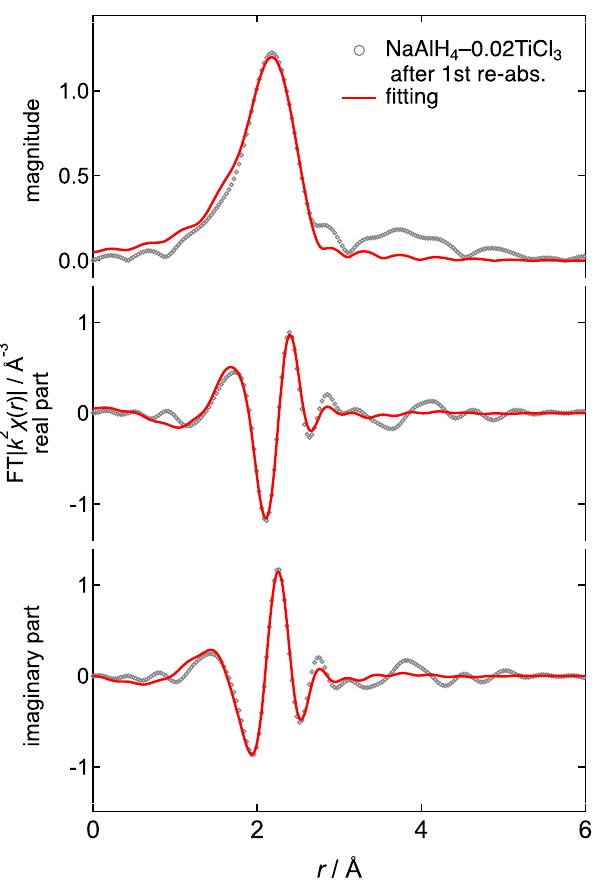
Figure 7. Fitting curves for radial distribution functions obtained from the EXAFS spectra of NaAlH 4 – 0.02TiCl 3 after the re-absorption of hydrogen.